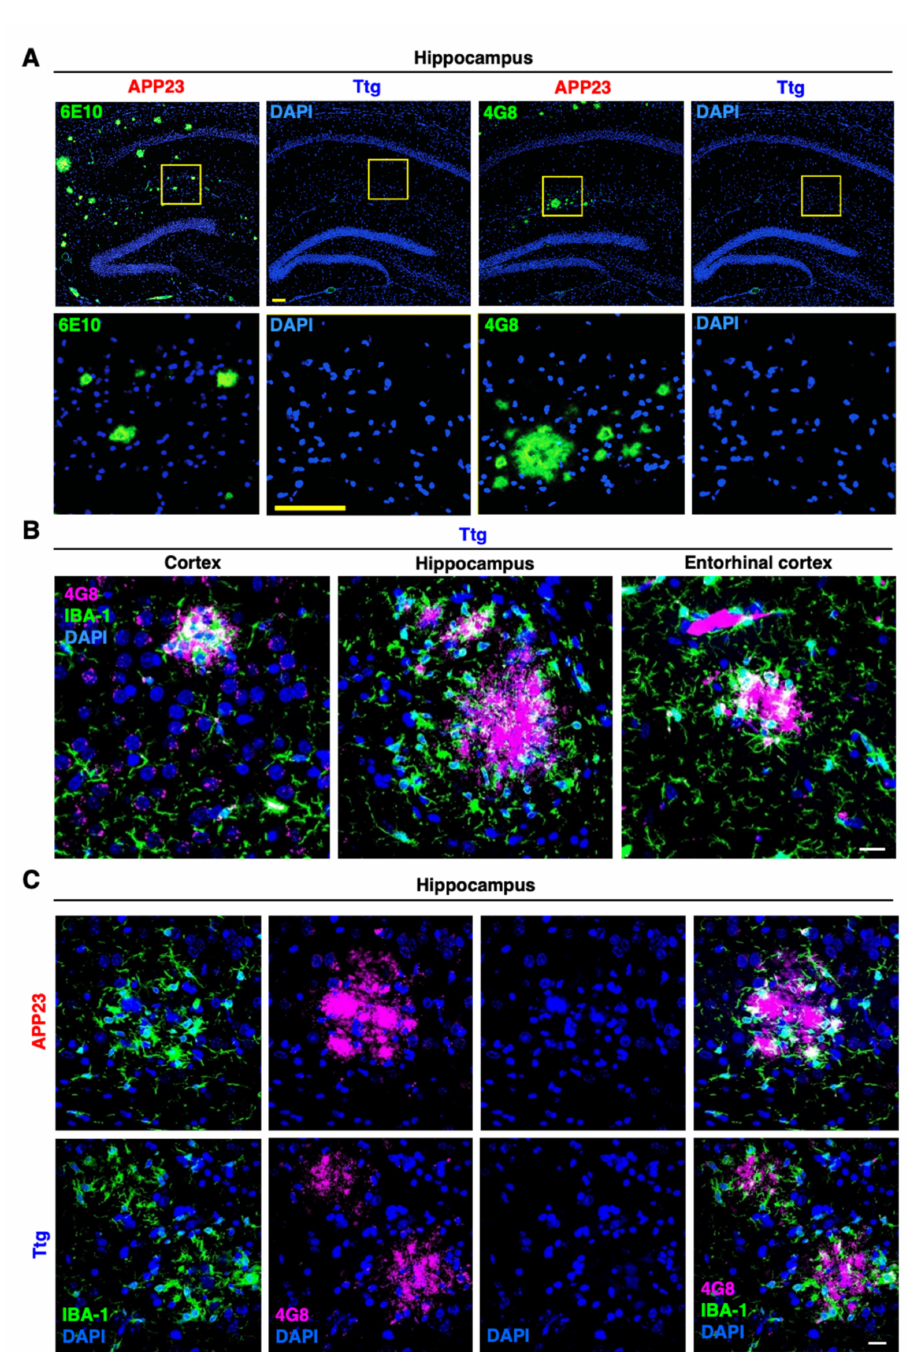
Figure 3. Plaque number and amyloid burden are reduced in Ttg mice compared to APP23 model without IKK2/NF- κ B signaling in astrocytes. ( A ) Representative panel displaying decreased im- munoreactivity to A β 6E10 (green, left) and 4G8 antibody (green, right) in the hippocampal area of Ttg mice compared to APP23 littermates at 12 months of age. ( B ) IF staining of A β 4G8-positive plaques (magenta) in relation to IBA-1-positive microglial cells (green), localized in different brain regions, namely Cortex, Hippocampus, and Entorhinal cortex of the Ttg animals. ( C ) Panel dis- playing different morphology and structure of A β 4G8-positive plaques (magenta), which appear smaller and less intensively stained in the Ttg mice compared to the APP23 littermates. Plaques are surrounded by IBA-1-positive microglia (green), which seem less ramified in Ttg mice compared to APP23 littermates. Nuclei are labeled with DAPI (blue). Pictures are from paraffin section (7 µ m thickness). Scale bar = 20 µ